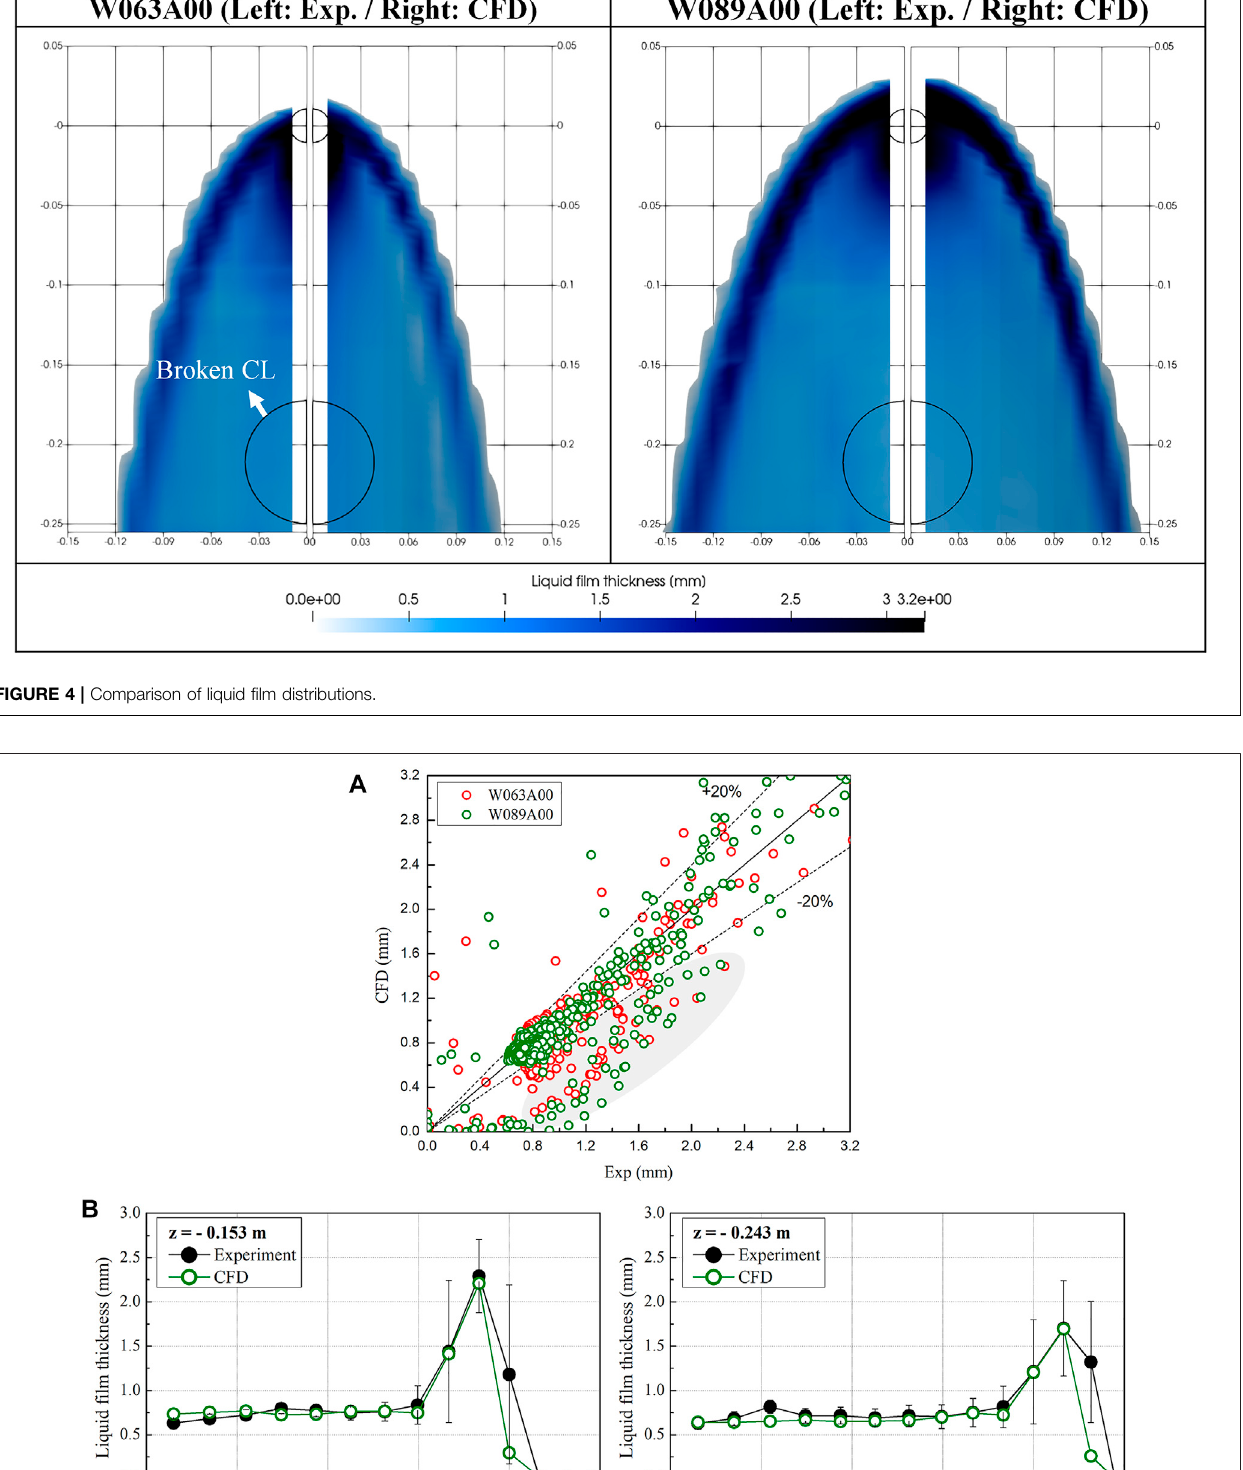
Frontiers in Energy Research |